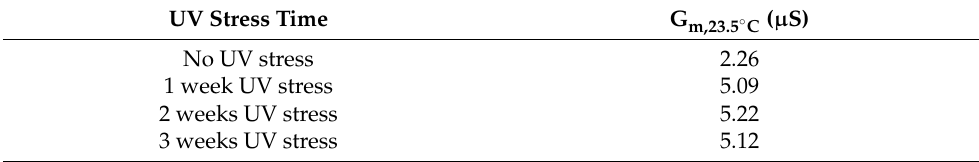
Table 2. Emulsion electrical conductance at 23.5 ◦ C as a function of UV stress